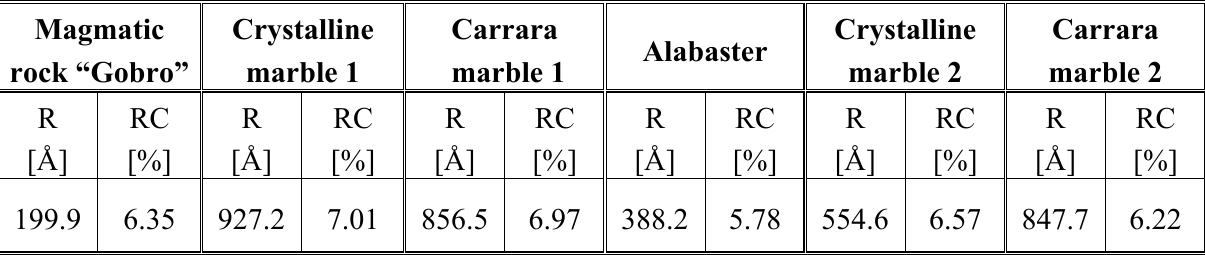
Table 5. Values of roughness (R) and reflection coefficient (RC) of samples in Figure 50. Magmatic Crystalline rock “Gobro” marble 1